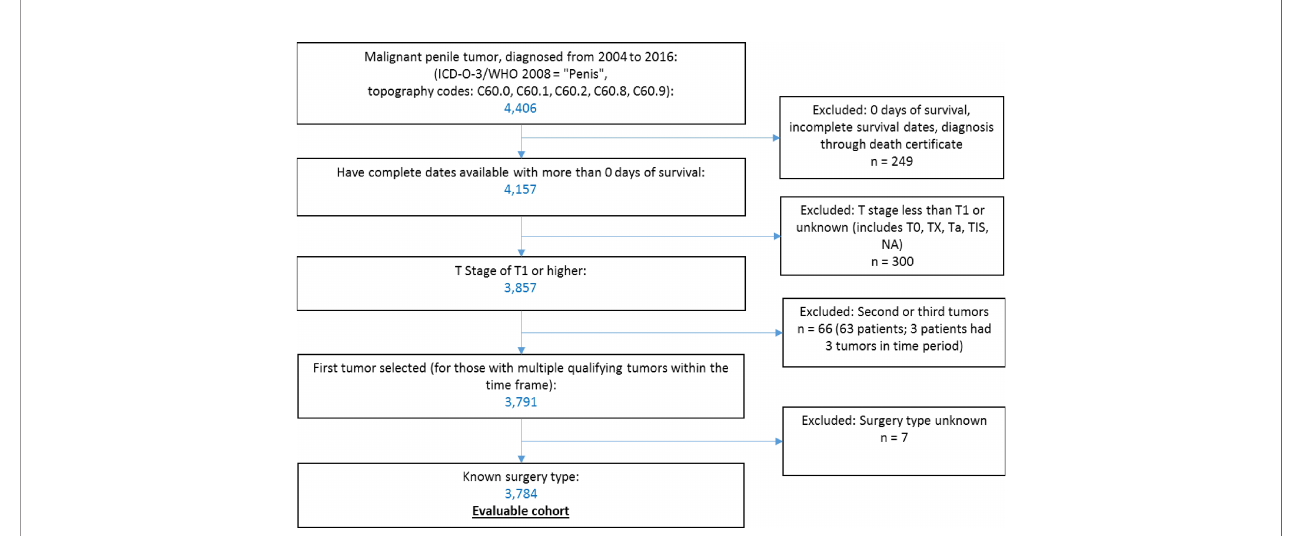
FIGURE 1 | Selection of the study